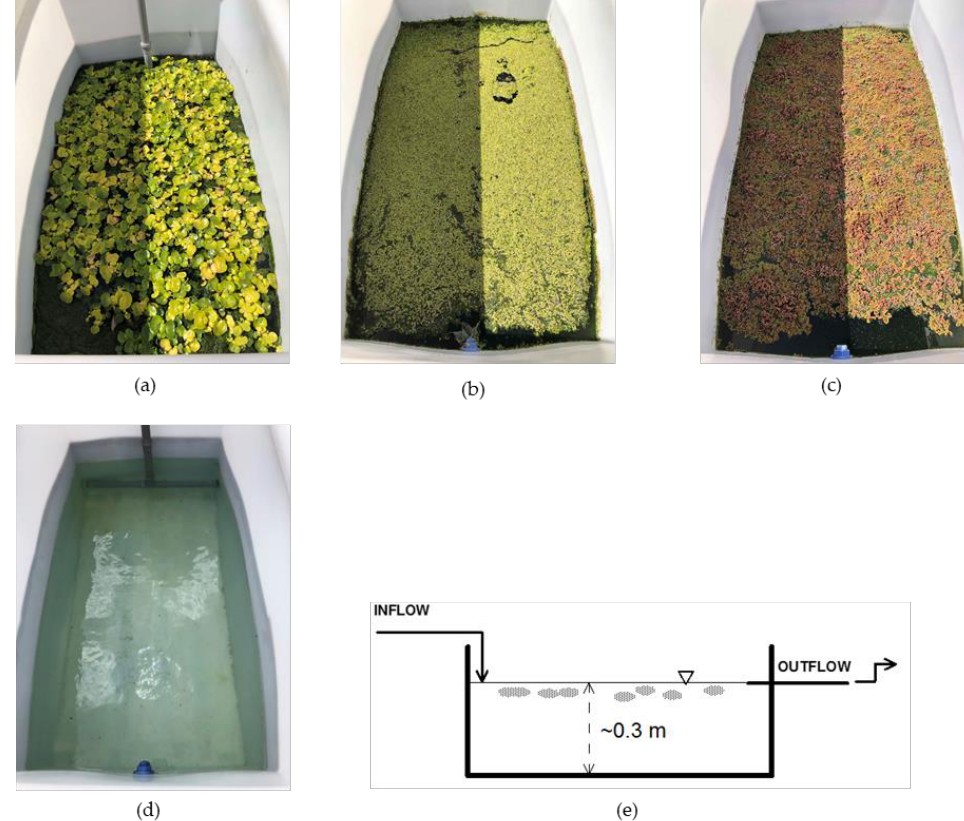
Figure 1. View of the main components of the experiment: ( a ) water hyacinth tank; ( b ) Lemna minor tank; ( c ) azola tank ( d ) control tank; ( e ) schematic representation of tanks.